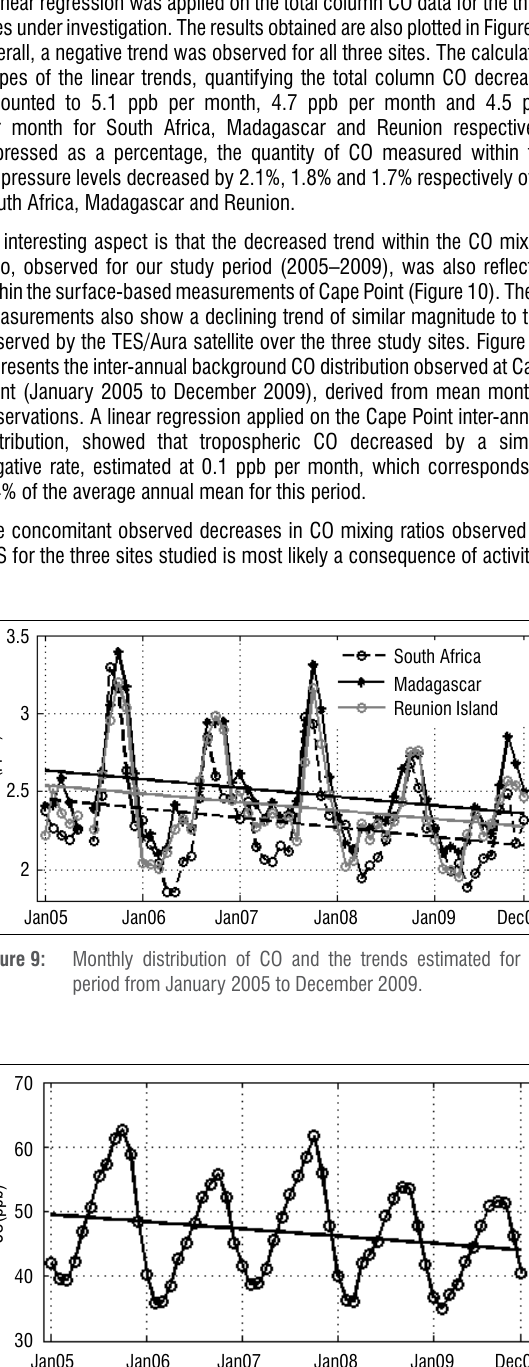
Figure 8: Seasonal distribution of CO and its variability observed from January 2005 to December 2009. The error bars in the figure represent the standard deviation of the monthly average.